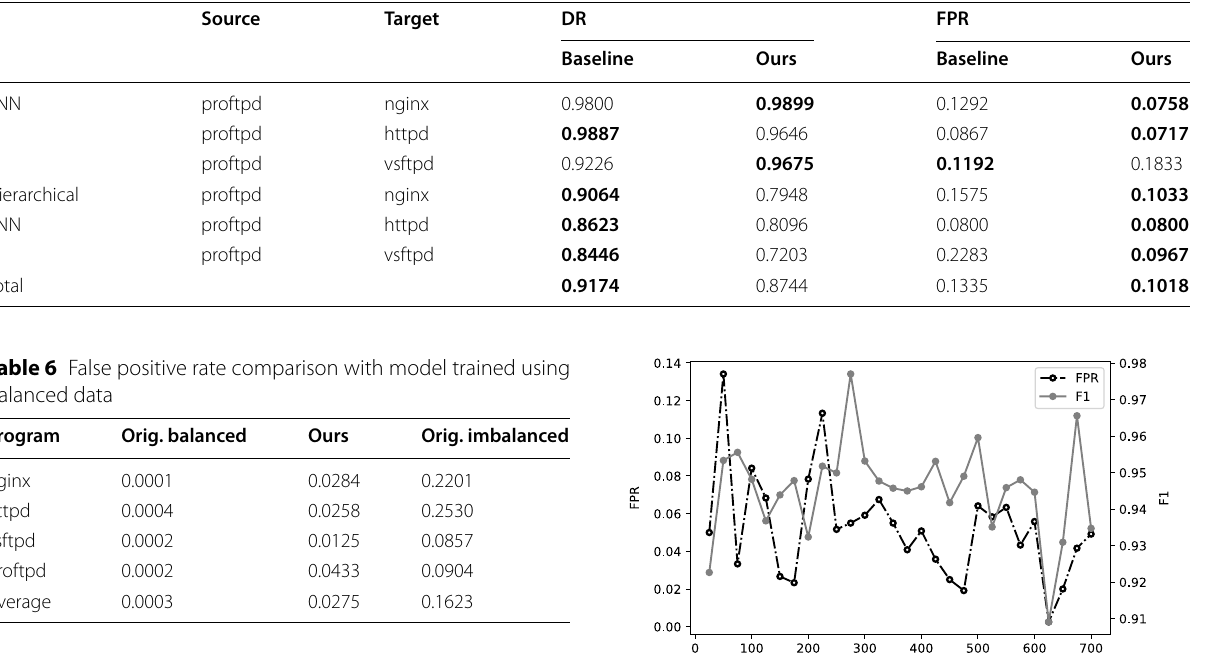
Table 5 Performance on RNN and hierarchical RNN